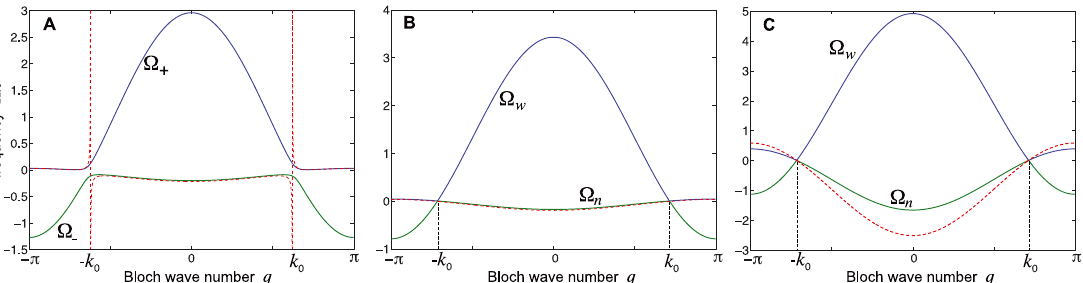
Figure 2: (A and B) Band diagram of the CROW structure with side-coupled optical cavities of Figure 1B for parameter values 𝜌 / J = 0 . 3, h = 0 . 8 and for (A) 𝜔 0 / J = − 0 . 75, (B) 𝜔 0 ∕ J = − 1 ∕ h = − 1 . 25. The dashed red curves in (A and B) show the band dispersion curve Ω ( q ) = − J ∕ h is not satisfied, the spectrum is gapped with noncrossing predicted by the asymptotic analysis [ Eq. (20) ]. In (A), the BIC condition 𝜔 0 , where k satisfies the resonance upper ( Ω + ) and lower ( Ω − ) bands. Note that Ω ( q ) shows a singularity at the Bloch wave numbers q = ± k 0 0 = 2 J cos k = − J ∕ h is satisfied and the spectrum is gapless, resulting in the formation of . In (B), the BIC condition 𝜔 condition 𝜔 0 0 0 (the BIC band) embedded in a wider band Ω 𝑤 . In this case, the predicted curve Ω ( q ) is almost overlapped with the exact narrowband Ω n ∕ J = − 1 ∕ h . A narrower band Ω of the narrow band. (C) Band diagram in the strong coupling regime ( 𝜌 ∕ J = 1 . 1, h = 0 . 8) with 𝜔 curve Ω 0 n n embedded in a wider band Ω 𝑤 is still observed in the exact model (solid curves). However, the asymptotic analysis [ Eq. (21) , dashed curve] fails to provide the accurate shape of the narrow